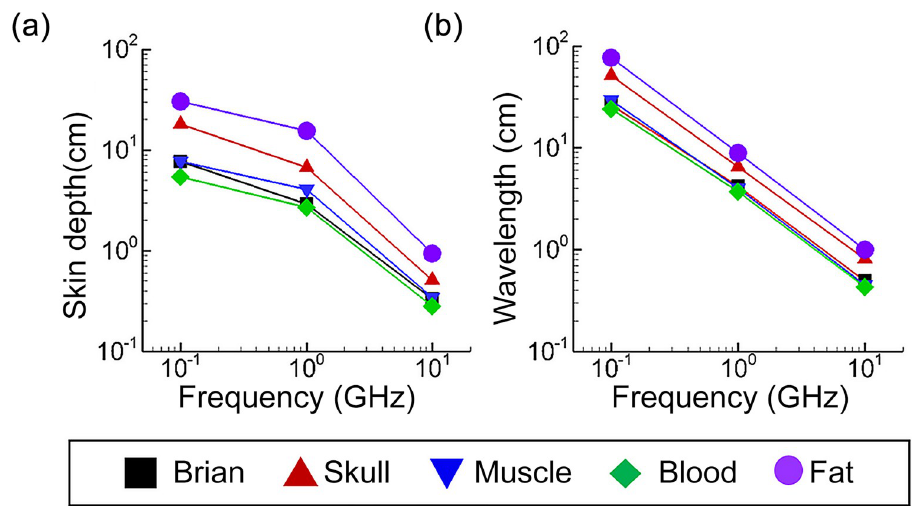
Fig 2. Skin depth and wavelength as a function of frequency for brain, skull, muscle, blood, and fat